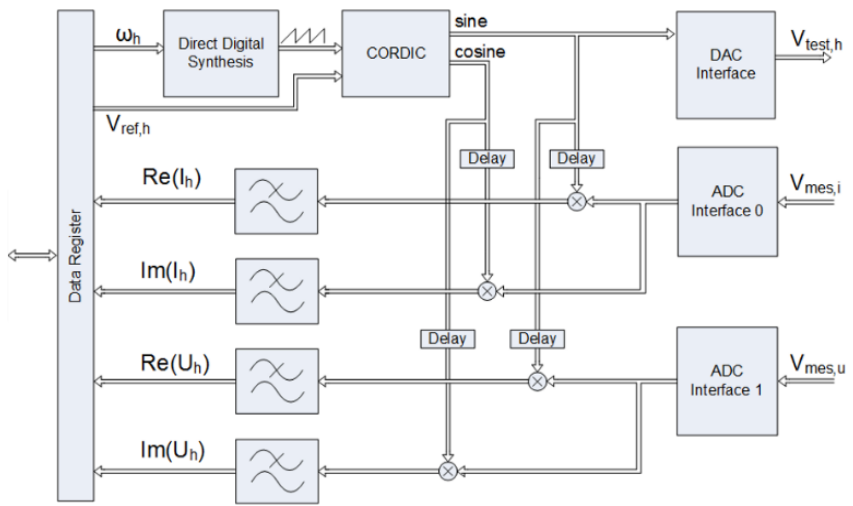
Figure 2. Block diagram of the IGOR-Meter developed by the HES-SO and setup for the grid impedance measurement.